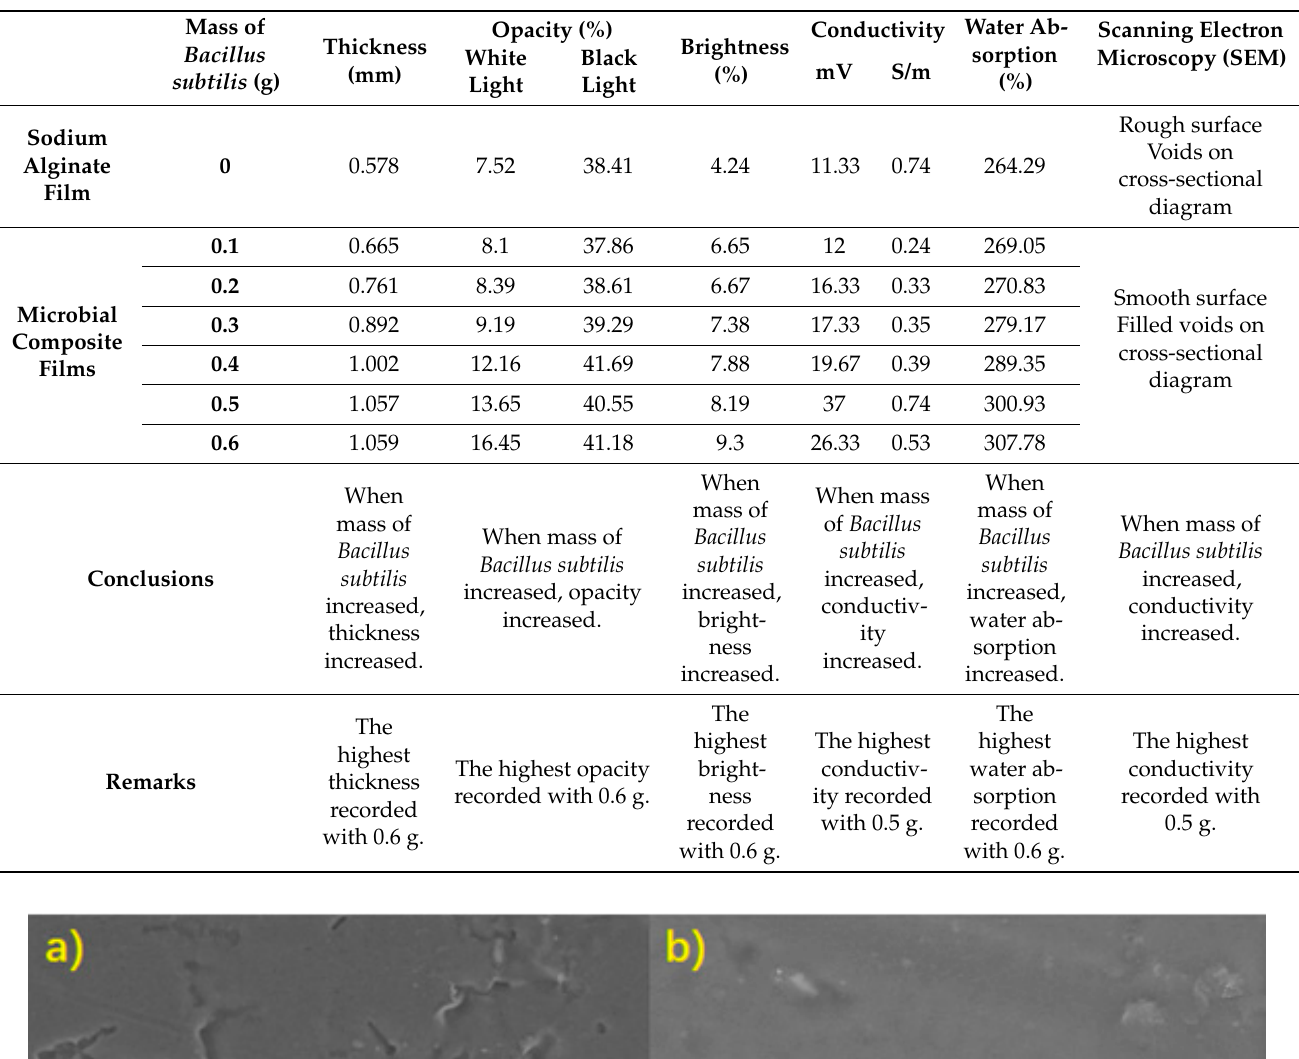
Table 2. Thickness (mm), opacity (white light and black light, %), brightness (%), conductivity and water absorption (%) and scanning electron microscopy (SEM) of sodium alginate film and microbial composite films.